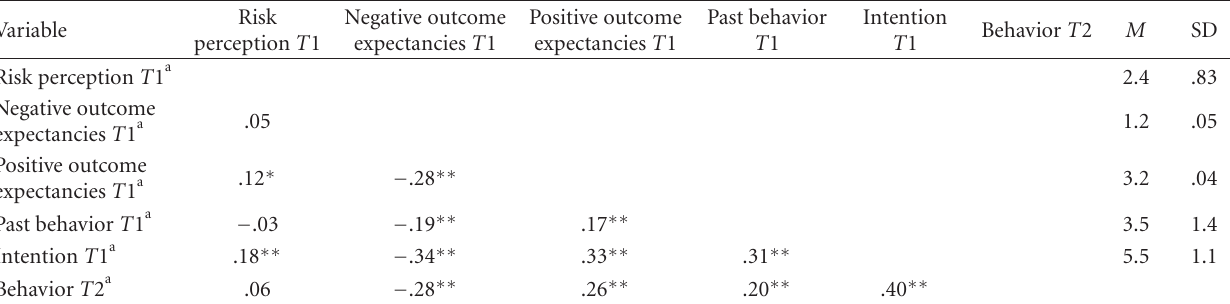
Table 1: Risk perception, positive/negative outcome expectancies, past behavior, intention T 1, and behavior T 2 (means, standard